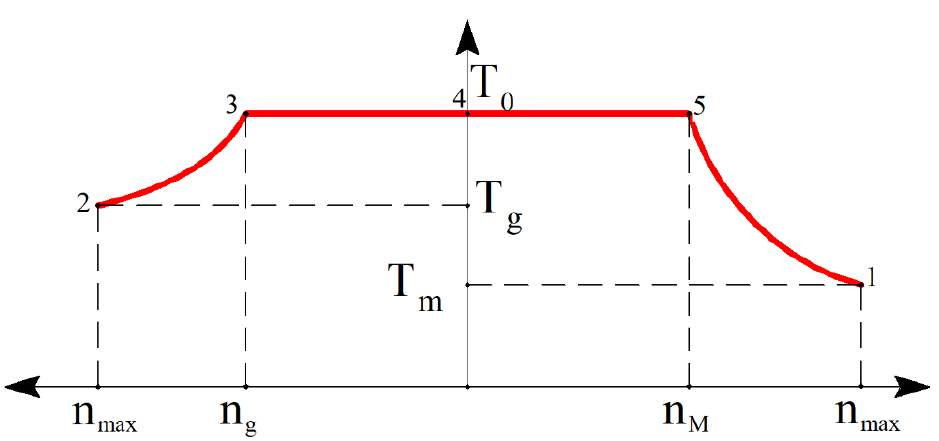
Figure 4. Demanded speed-torque curve of the subway traction